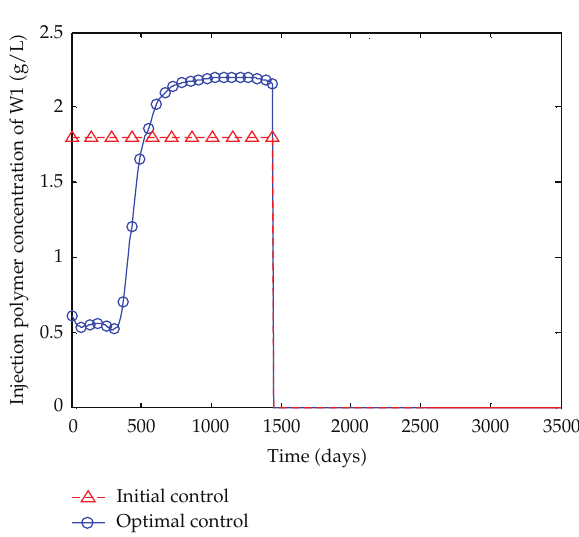
Figure 4: Injection polymer concentration of well W1.